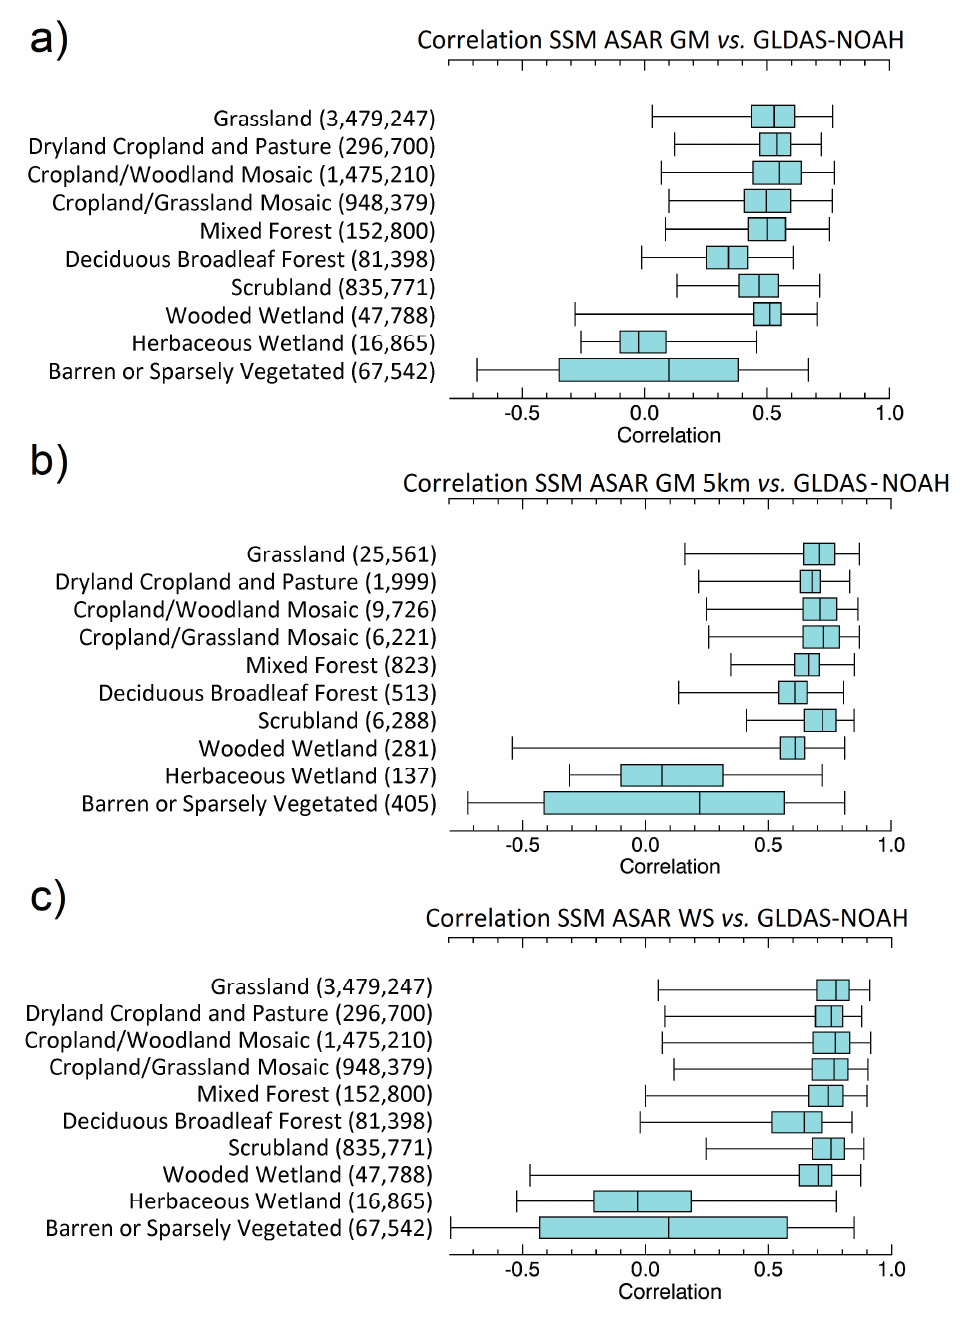
Figure 13. The box-plot representation of the Pearson correlation ( R ) results stratified by the Land Use/Land Cover system from U.S. Geological Survey Global Land Cover Characteristics over Zambezi catchment in southern Africa. The boxes show the median, 25th and 75th percentiles; the lines represent minimum and maximum values after outlier removal (first and 99th percentile). The amount of 5-km Advanced Synthetic Aperture Radar (ASAR) pixels used for the evaluation for each class is shown in brackets behind the class name. The R values were computed for the Noah model from the Global Land Data Assimilation System (GLDAS-NOAH). ( a ) One-kilometer resolution ASAR Global Monitoring (GM) Surface Soil Moisture (SSM); ( b ) 5-km aggregated ASAR GM SSM; and ( c ) 1-km aggregated ASAR Wide Swath (WS)